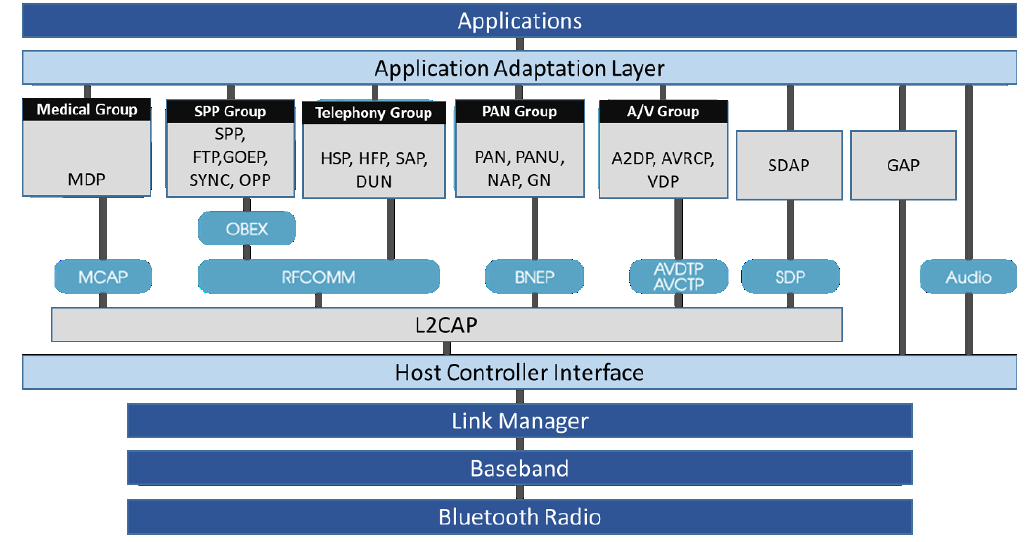
Figure 1. Bluetooth profiles and their application domains.